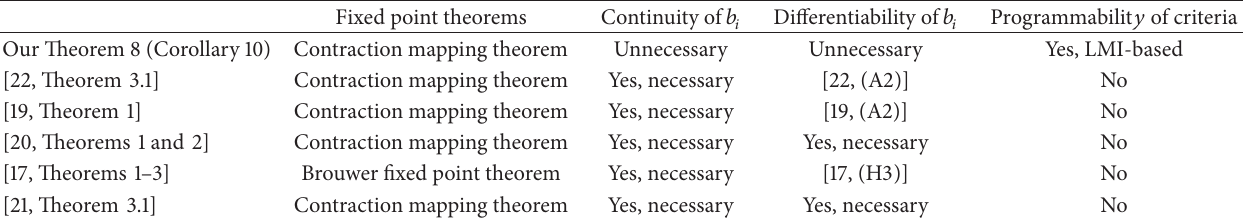
Table 1: Comparing our Theorem 8 and Corollary 10 with other existing criteria on CGNNs derived by fixed point